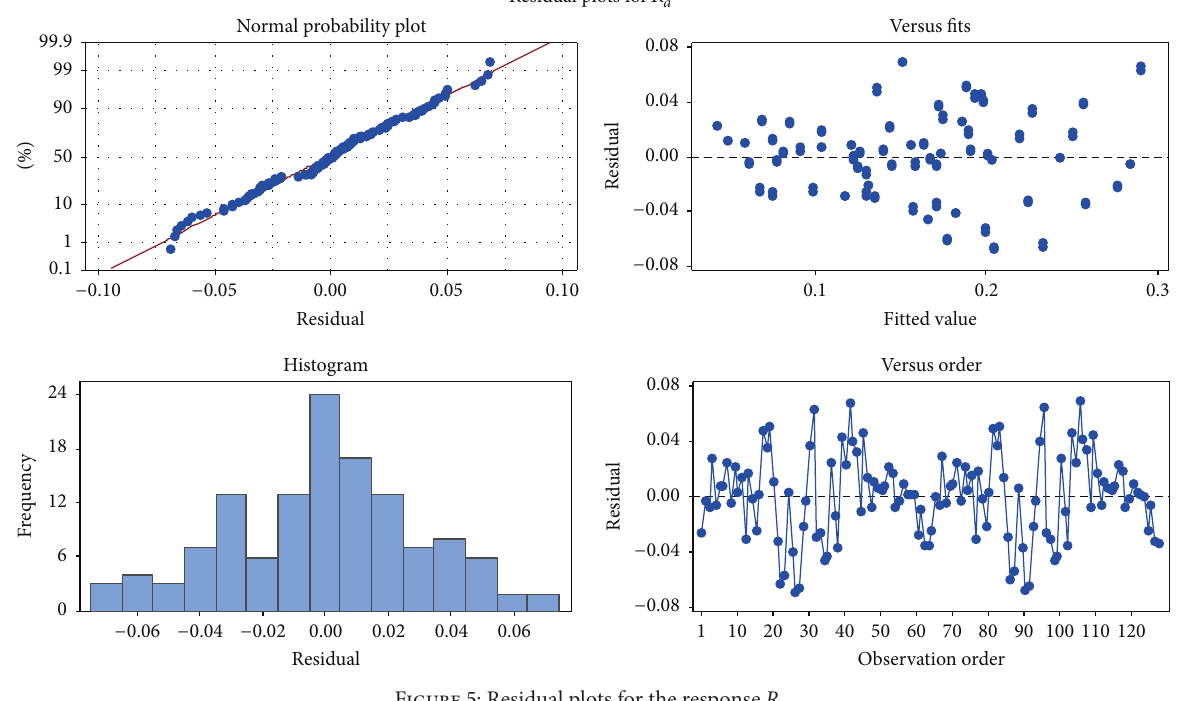
Figure 5: Residual plots for the response 𝑅 𝑎 .